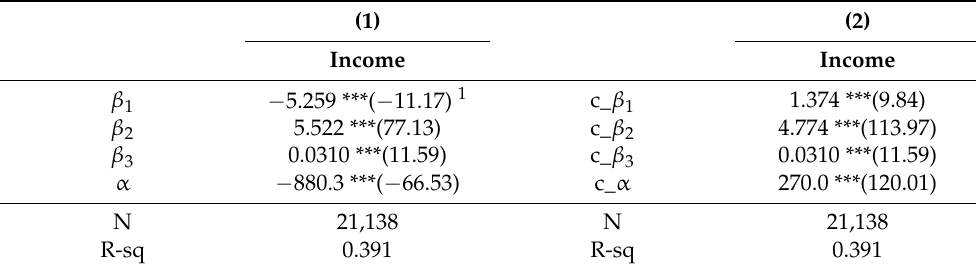
Table 8. The result of the moderating effect of the digital financial inclusion